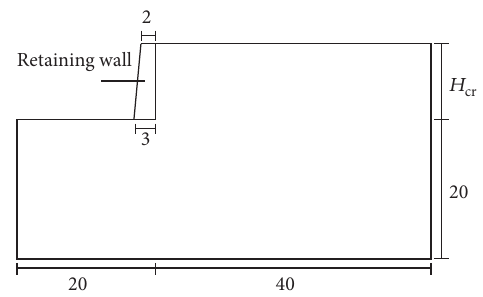
Figure 9: Contour of ultimate strain.